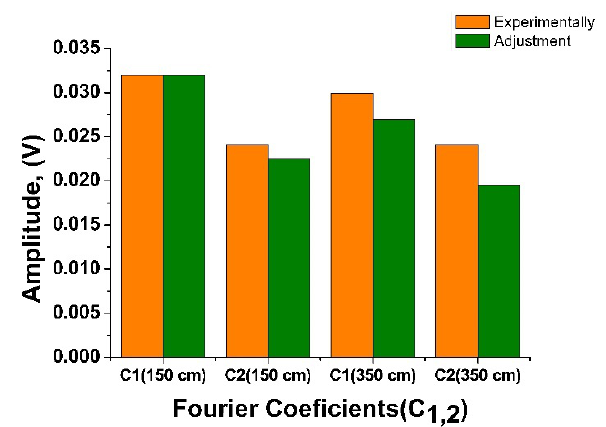
Figure 5. Experimental and theoretical Fourier coefficients.